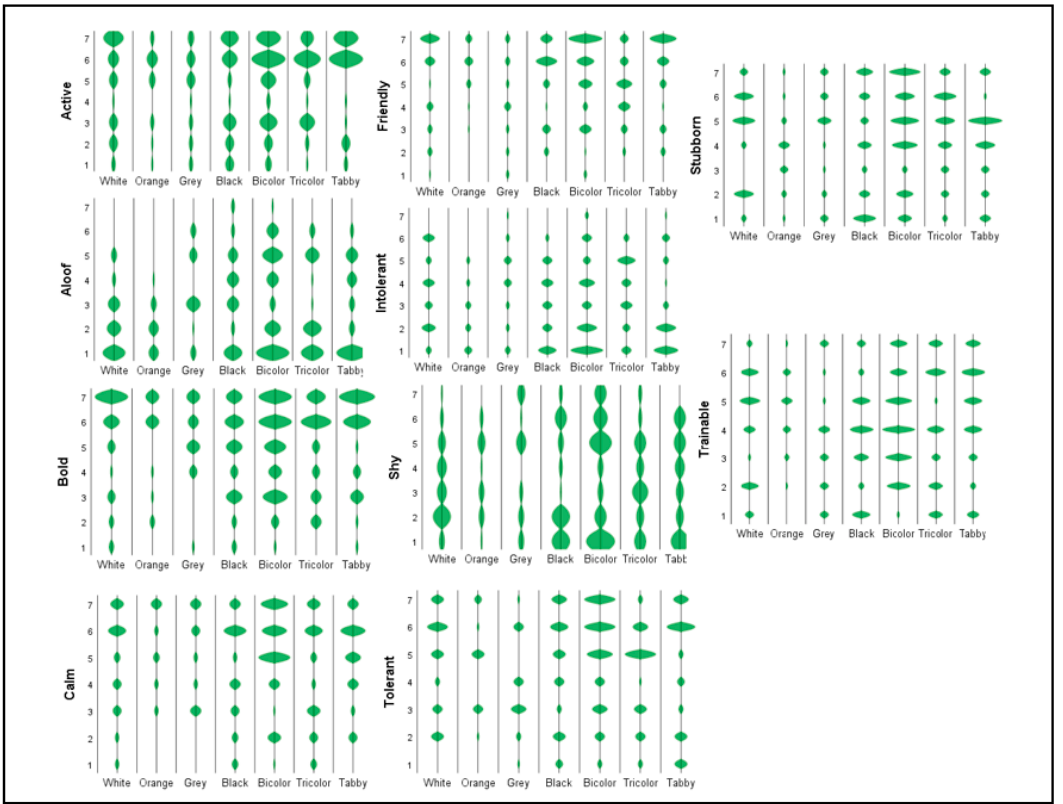
Figure 1. Personality traits based on cat coat color: individual distribution.